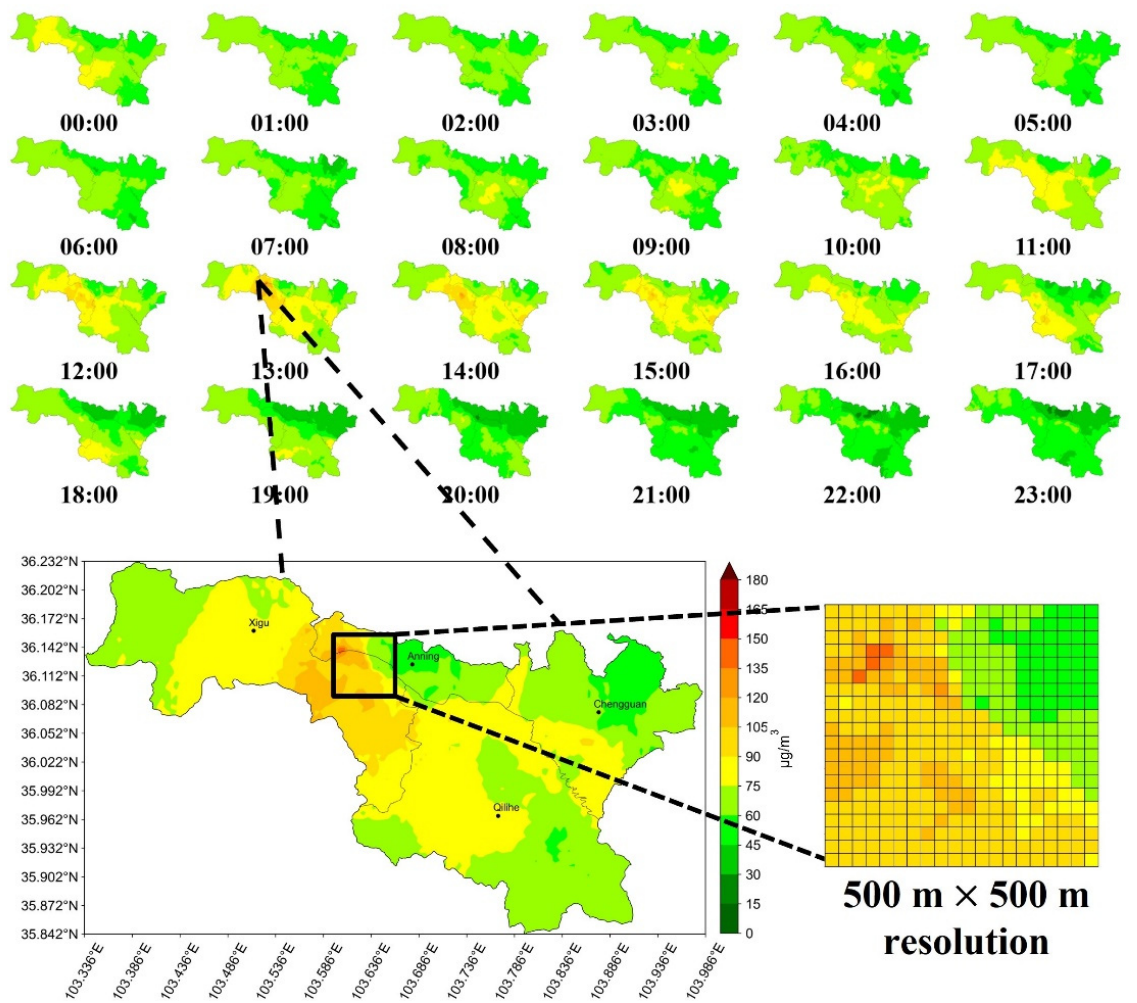
Figure 5. Hourly PM 2.5 concentration distribution on a typical weekday (8 February 2022) in Lanzhou, as inferred by our